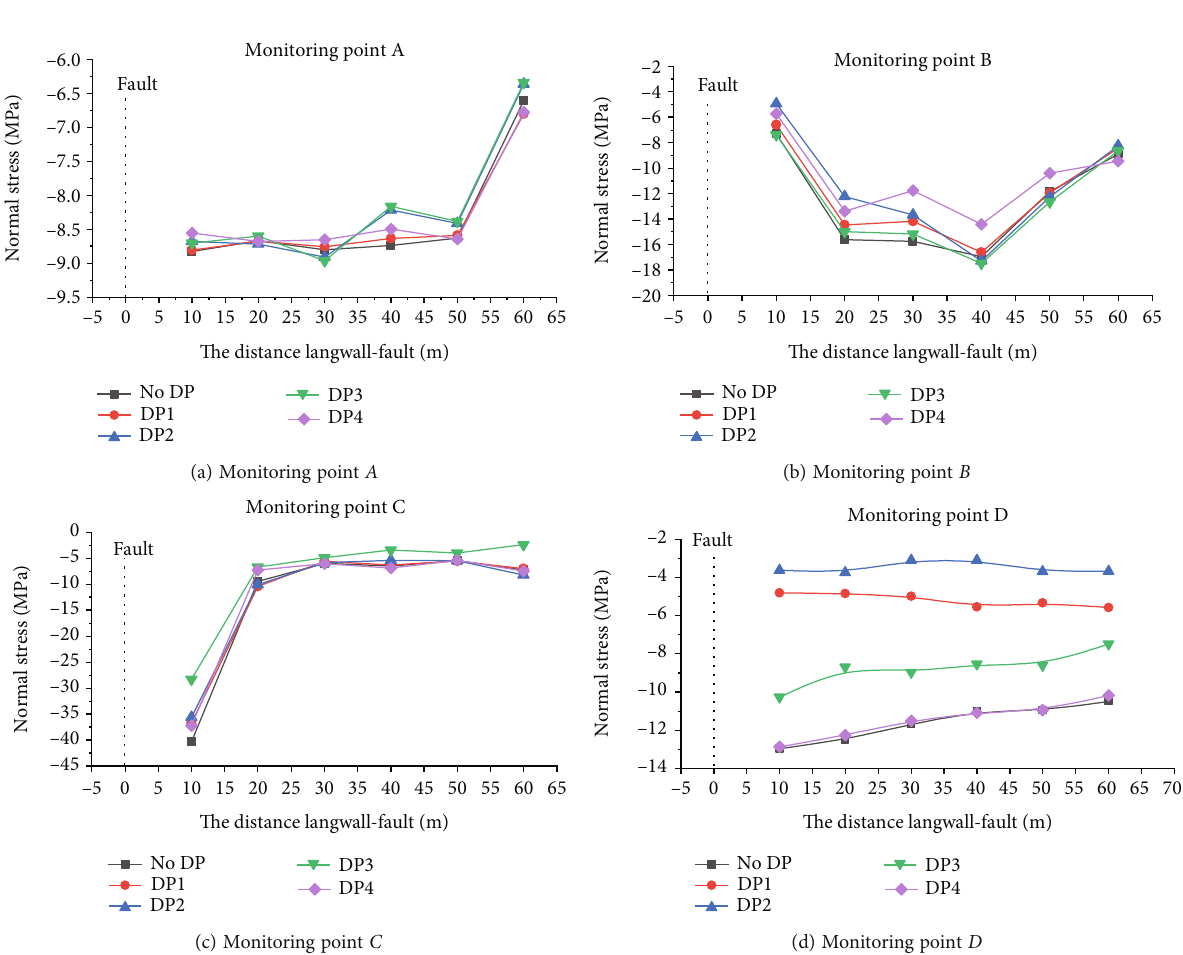
Figure 11: Vertical stress changes of four monitoring points in the footwall of the fault under external